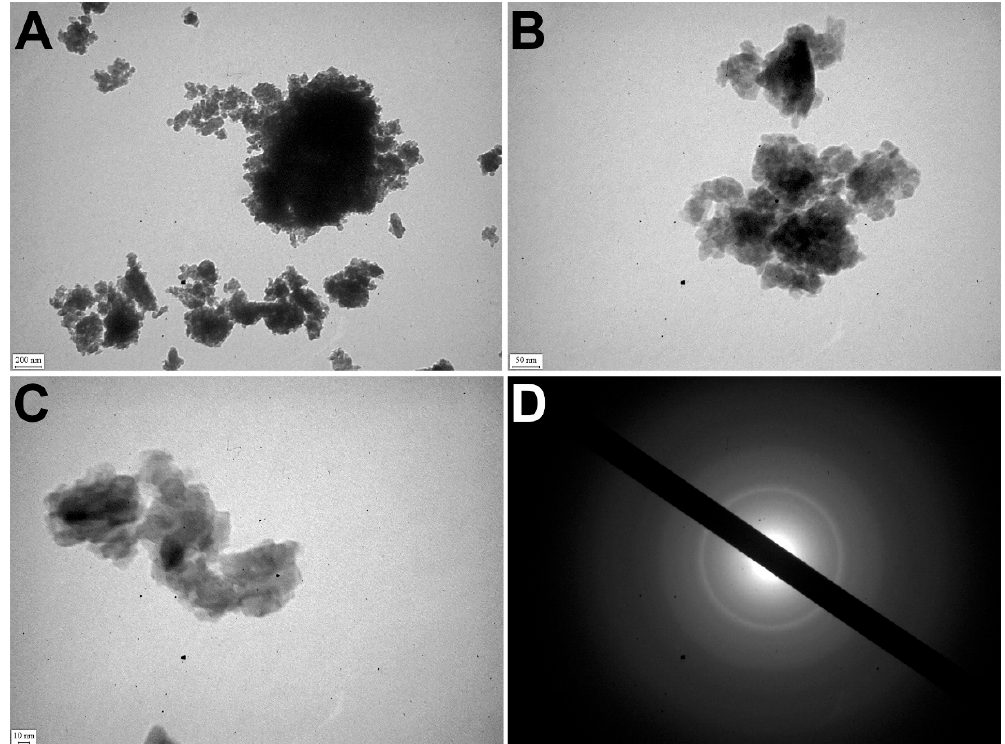
Figure 4. TEM of OC calcified samples. ( A – C) TEM images of nanocrystals; ( D ) ED image.